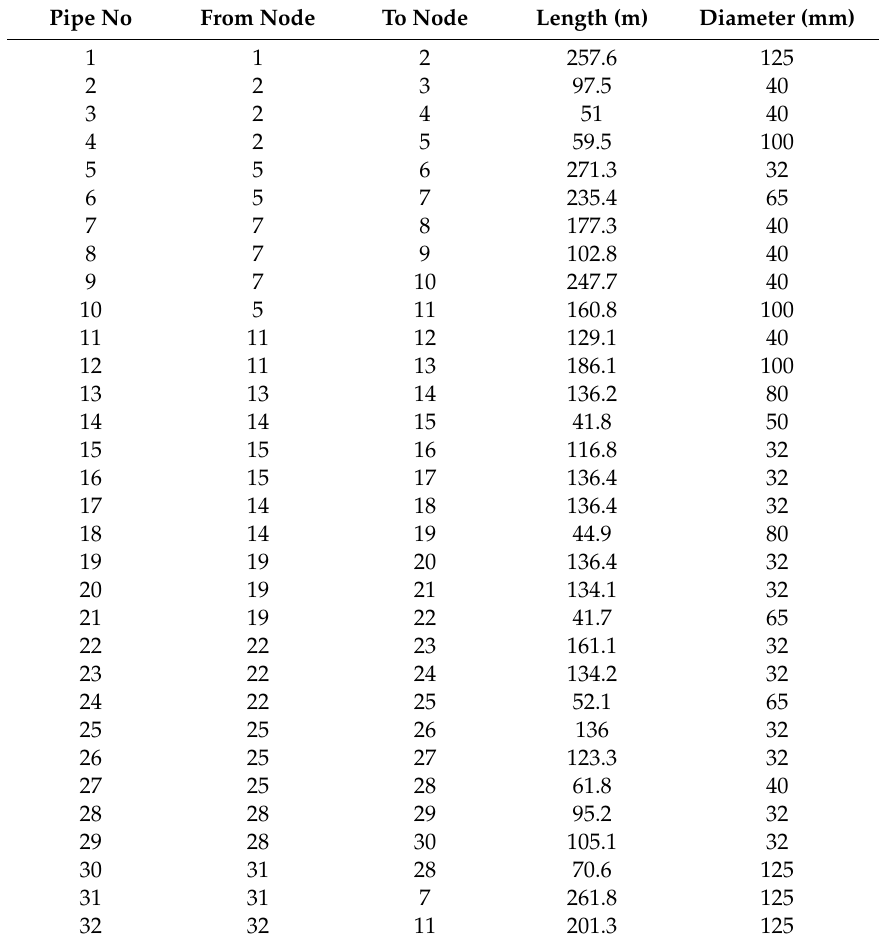
Table A4. Thermal system parameters of the